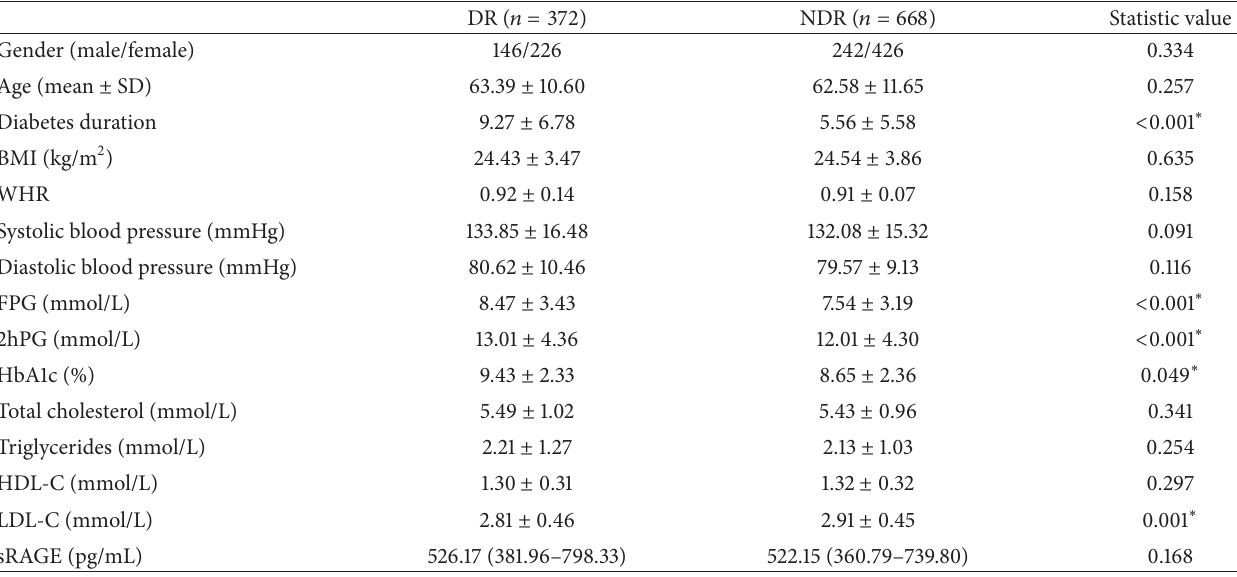
Table 1: Clinical characteristics of DR and NDR groups.